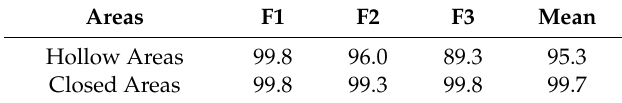
Table 3. The accuracy comparison of BWFP between hollow and closed areas in Building 2 (%).